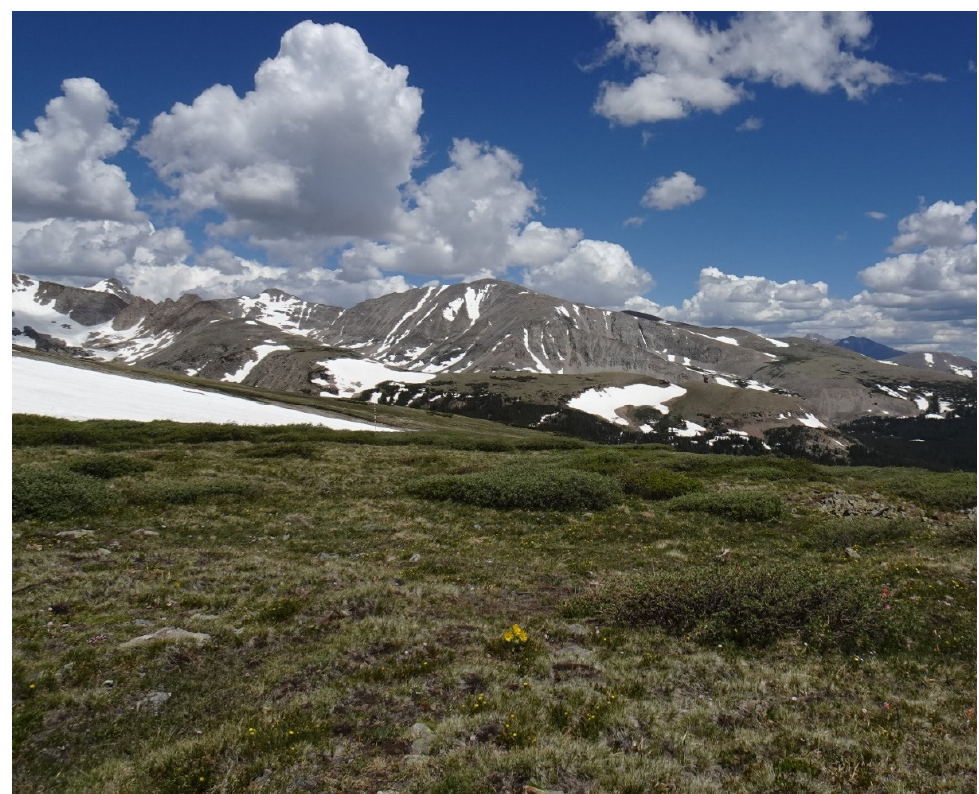
Figure 1. Typical alpine tundra found at Niwot Ridge (ca 3500 m.a.s.l., 40°3 ′ N Lat., 105°35 ′ W Long). The dry meadow in the foreground has been snow-free for nearly a month, while snowbed communities and some of the moist meadows have yet to emerge from the snow. Willow (here Salix glauca and S. planifolia ) has increased exponentially at this site in recent decades ([26]; photo by C. M. Tate).